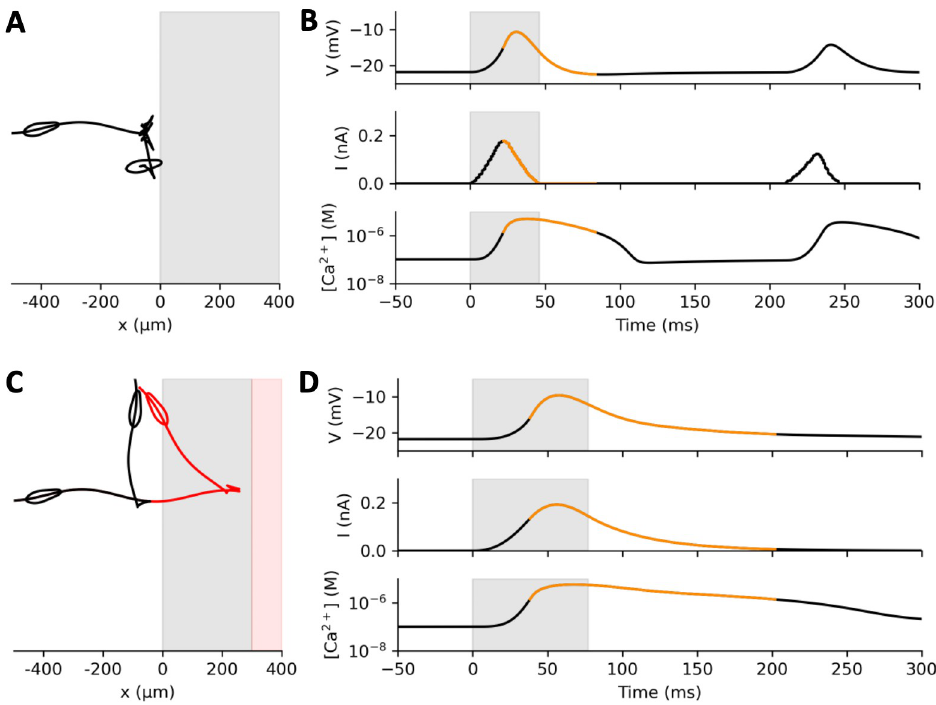
Fig 10. Interaction of a model Paramecium with a generic stimulus, modelled as a positive current proportional to the cell area within the stimulus area. A, Trajectory of the model doing several avoiding reactions against the stimulus. B, Membrane potential (top), stimulus current (middle) and intraciliary calcium concentration (bottom) at the first contact. Contact occurs at the boundary with the shaded region. Orange curves indicate backward swimming. Several weak avoiding reactions occur in succession. C, Trajectory of the model where sensory transduction has a 40 ms activation/deactivation time constant. In red, the stimulus is placed 300 μ m further away. D, Same as B, for the black trajectory in C. The stimulus current lasts longer and peaks after the organism has started reacting, resulting in a stronger avoiding